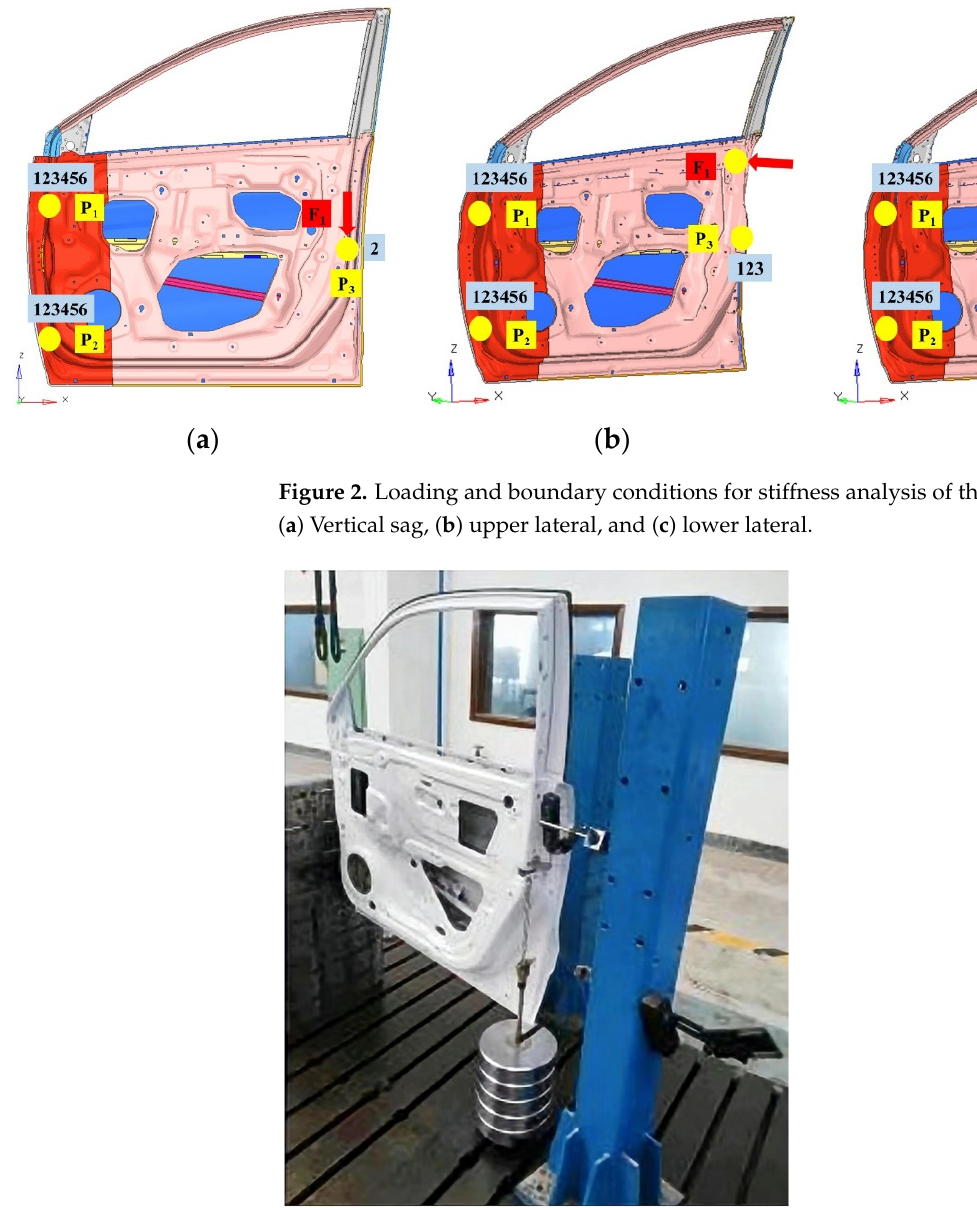
Figure 3. Experimental test of stiffness for the automotive door.